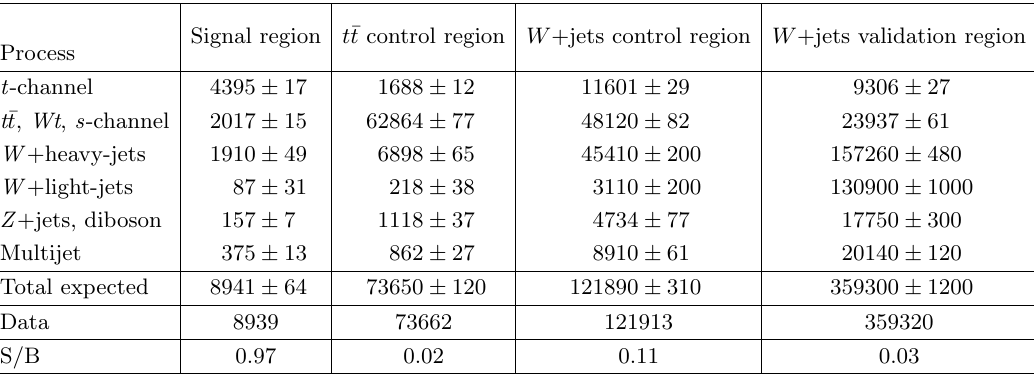
Table 1. Predicted and observed data event yields are shown for the merged electron and muon channels in the signal, t (cid:22) t and W +jets control and validation regions. The multijet background is estimated using data-driven techniques, while contributions from simulated W +jets, top-quark backgrounds and t -channel event samples are normalised to the results of a maximum-likelihood (cid:12)t to event yields in the signal and control regions. The uncertainties shown are statistical only. Individual predictions are rounded to two signi(cid:12)cant digits of the uncertainty while \Total expected" corresponds to the rounding of the sum of full-precision individual predictions. The expected S/B ratios are also